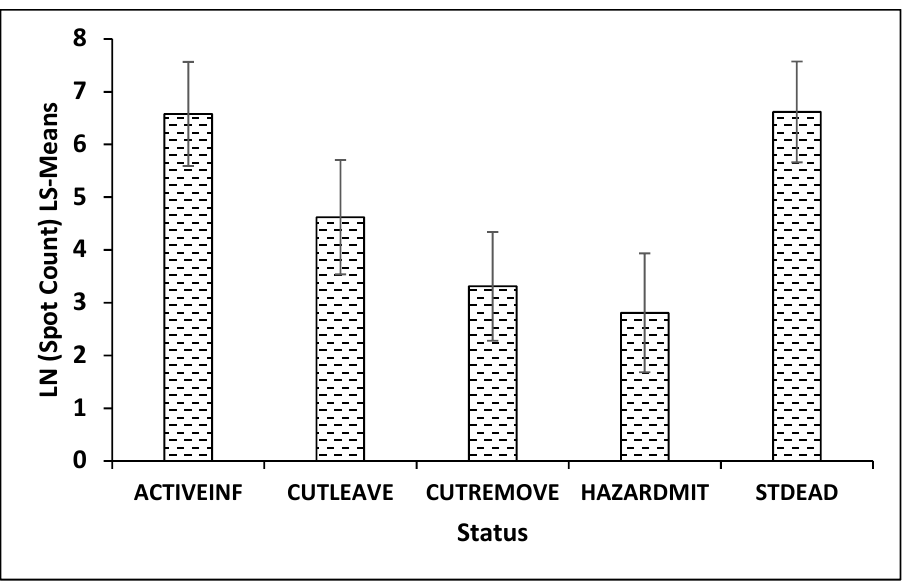
Figure 4. Least squares means for logged southern pine beetle treated spots on the Bienville National Forests over the years 2016 to 2019. ACTIVEINF = active infestation, CUTLEAVE = cut and leave, CUT_REMOVE = cut and remove, HAZARDMIT = hazard tree mitigation, and STDEAD = standing dead. Error bars represent lower and upper 95% confidence intervals. Table 2. Least squares means (natural logged) for southern pine beetle spots by status, and incident rate ratios for the status referenced to spots containing standing dead